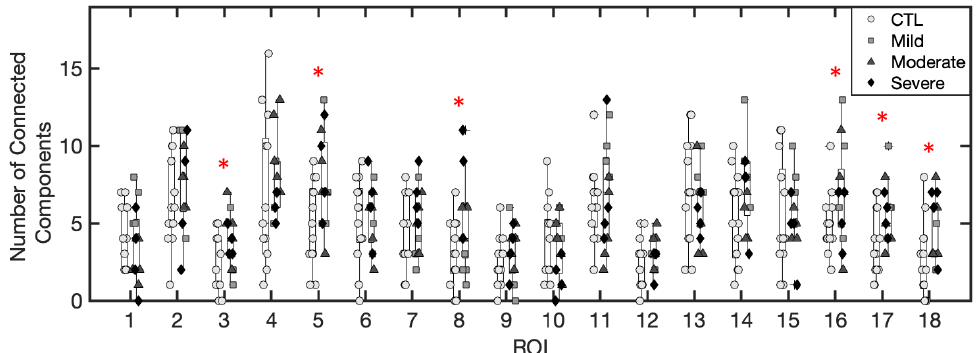
Figure 7. The number of connected components per ROI in control and CF subjects. ROIs 1–9 are from the right lung and ROIs 10–18 are from the left lung. Red asterisks denote a statistically significant increase in CF subjects when compared to controls ( p < 0.05).